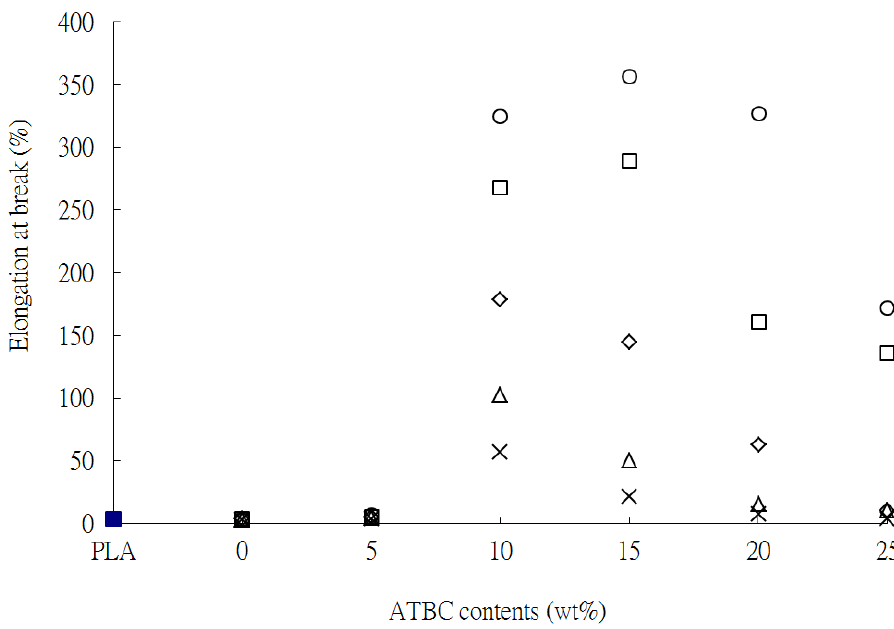
Figure 3. Elongation at break vs. ATBC content for (■) PLA; (○) PLA (□) PLA (×) PLA